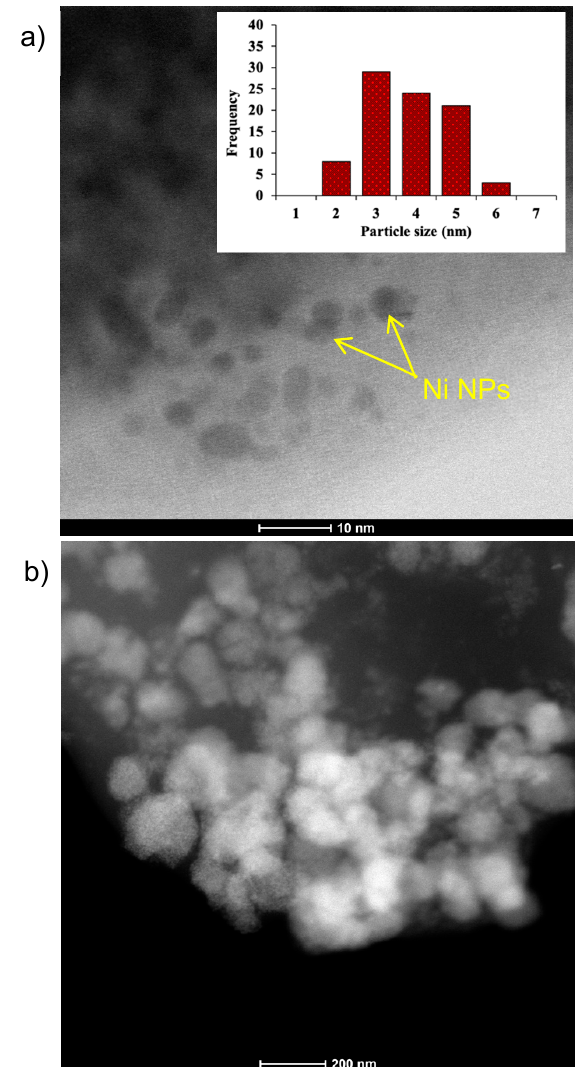
Figure 2. Transmission electron microscopy images of NiTSNH 2 catalyst. ( a ) TEM micrograph with particle size distribution histogram (insert) and ( b ) HAADF-TEM.